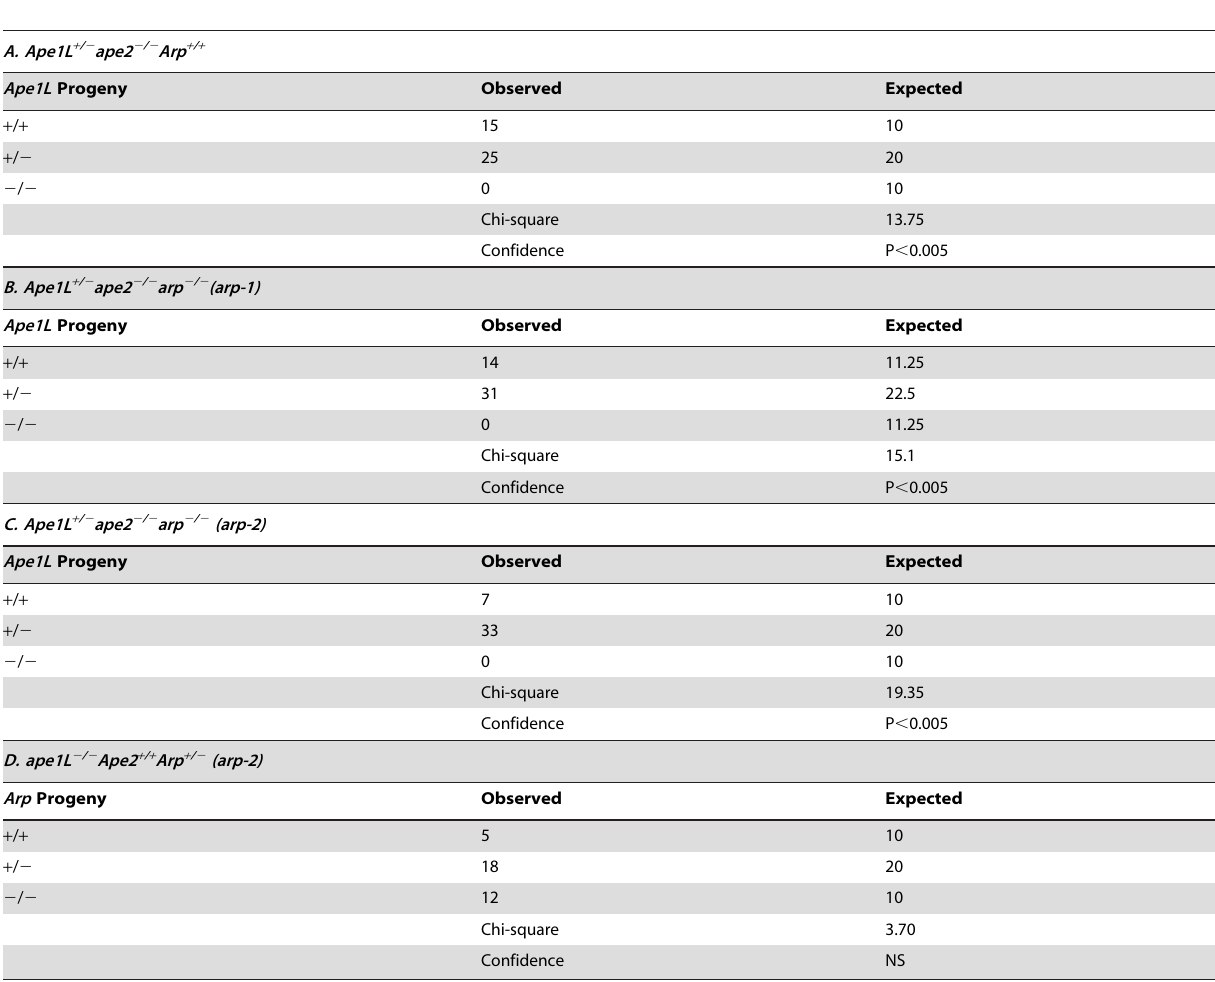
Table 2. Genotypes of progeny resulting from self-crosses of strains with various combinations of mutations in Ape1L , Ape2 , and Arp